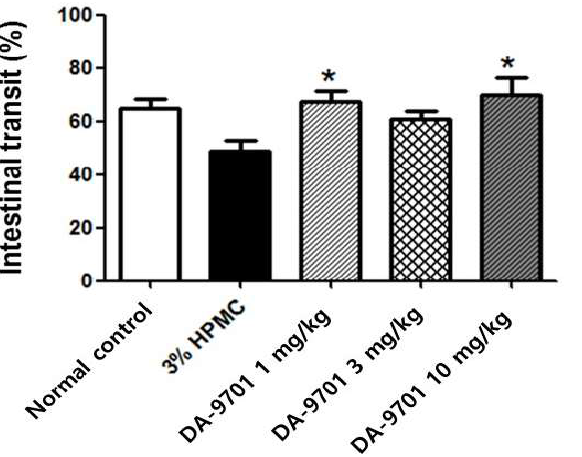
Figure 9. Effect of DA-9701 on intestinal transit in streptozotocin-induced diabetic mice. Intestinal transit was significantly decreased in streptozotocin-induced diabetic mice compared to normal control and improved in DA-9701 treatment group compared to placebo (3% HPMC-treated) group. The intestinal transit was 67 ± 4.0%, 60 ± 4.2%, 70 ± 6.6% in the treatment with 1 mg/kg, 3 mg/kg, and 10 mg/kg of DA-9701, and 49 ± 4.0% placebo groups, respectively. In particular, the intestinal transit improved significantly with 1 mg/Kg and 10 mg/kg of DA-9701 treatment compared to placebo (n = 10 in each group) * p < 0.05.